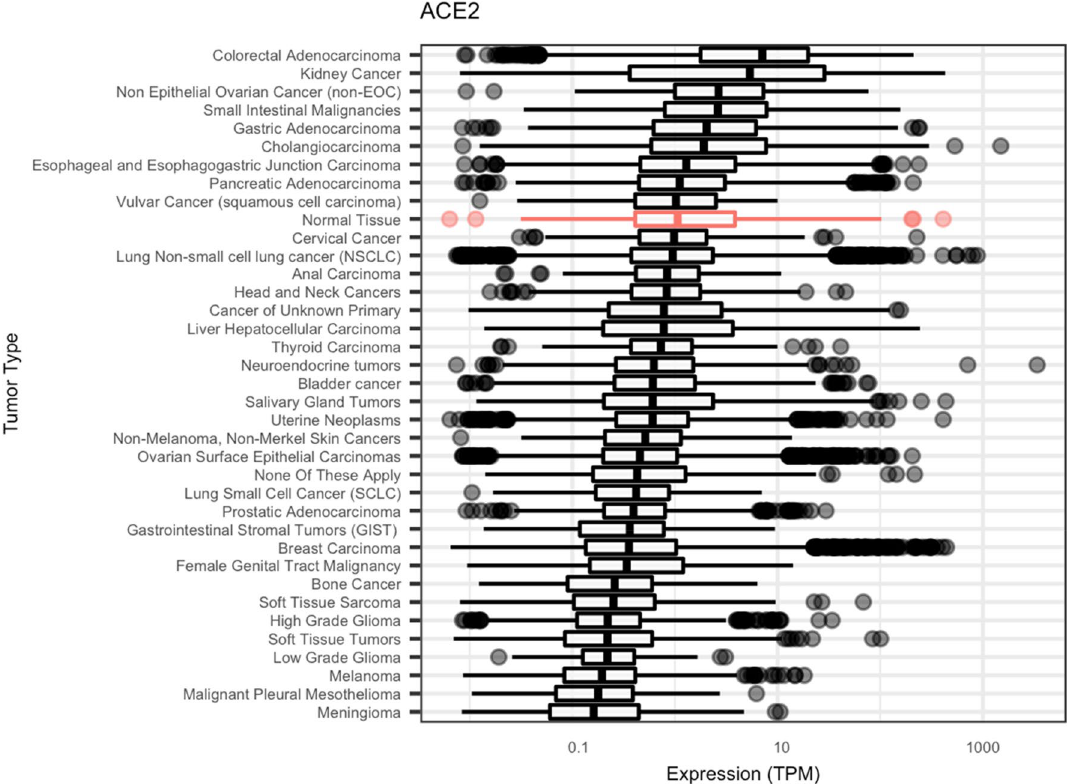
Figure 1. ACE2 gene expression in normal and cancerous tissues. Box plots indicate the median and upper/ lower quartiles, with individual data points representing outlier values greater than 1.5 × the interquartile range above or below the upper or lower quartile,